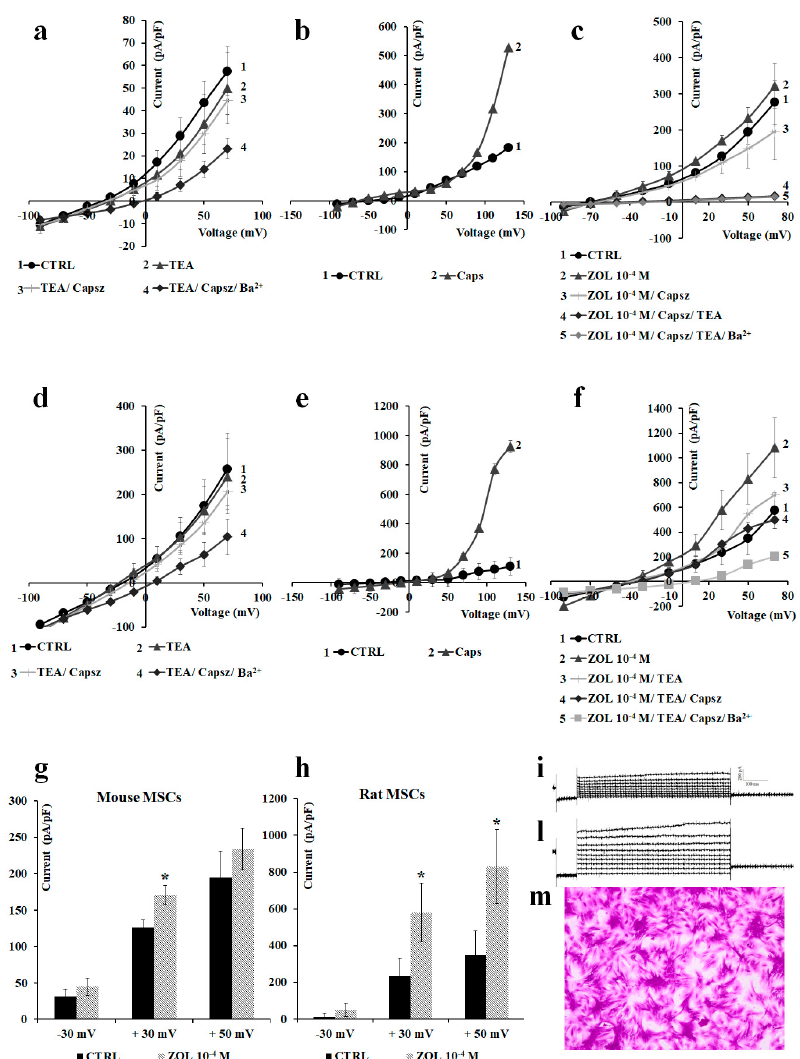
Figure 7. Pharmacological characterization of the inwardly and outwardly macroscopic K + currents and transient receptor potential (TRP) channel currents recorded in mouse and rat mesenchymal stem cells (MSCs) in whole-cell configuration. Current was recorded using physiological K + concentration in the bath and pipette, and was obtained in response to voltage pulses from − 90 to + 70 mV in 20 mV steps, starting from HP = − 60 mV (mV). Each point represented the mean ± SEM of 1–10 patches. ( a ) In mouse MSCs (number of patches = 1–5 patches) and ( d ) rat MSCs (number of patches = 1–5 patches), there was an inhibitory response of the control currents to TEA (5 × 10 − 3 M) and capsazepine (Capsz) (10 − 6 M). ( b ) In murine MSCs and ( e ) rat MSCs, there was an activating response of control currents to capsaicin (Caps) (10 − 5 M). ( c ) In murine MSCs and ( f ) rat MSCs, there was an activating response of control currents to ZOL (10 − 4 M) that was fully inhibited by co-application of capsazepine (10 − 5 M) and TEA (5 × 10 − 3 M). ( g ) Change of current amplitude at − 30, +30, and +50 mV (Vm) after ZOL application (10 − 4 M) on mouse MSCs and ( h ) rat MSCs. * Data are significantly different with respect to the controls for p < 0.05 as determined by Student t -test. ( i ) Sample traces of control (CTRL) current and ( l ) ZOL-evoked instantaneous current in rat MSCs. ( m ) Image of murine MSCs as observed by Olympus CX41 4 × magnification after crystal violet